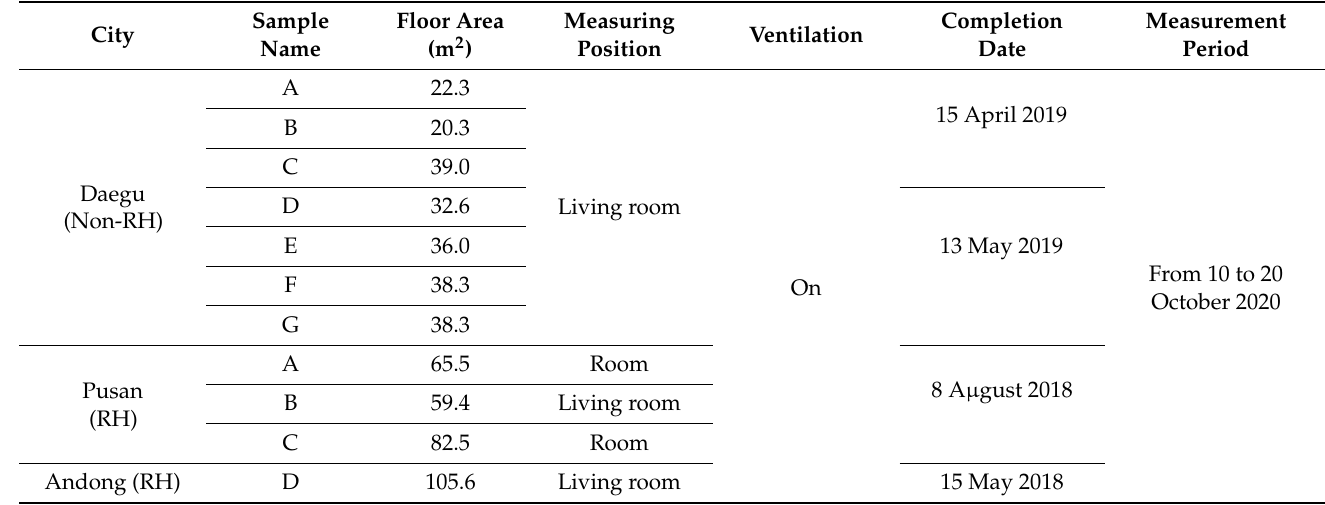
Table 1. The overview of the